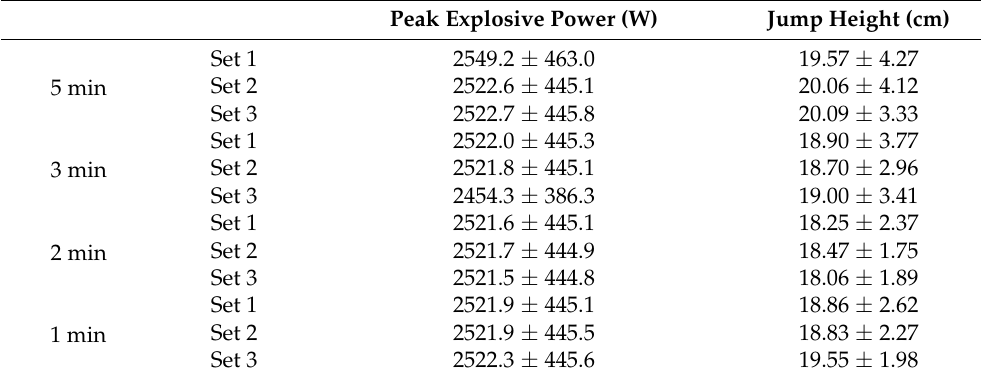
EMG indices, EMG intensity and MPF are used as indicators of muscle fatigue. Table 3 lists the EMG intensity of the 9 tested muscles at each set and group. When muscles are fatigued, the EMG intensity should increase whereas the MPF should decrease. However, we did not find significant differences in EMG intensity for the tested muscles among sets and among groups for GM ( p = 0.34), RF (p = 0.57), VM (p = 0.43) VL ( p = 0.55), BF ( p = 0.09), TA ( p = 0.56), MG ( p = 0.82), LG ( p = 0.84), and SO ( p = 0.44). Table 4 shows the EMG mean power frequency (MPF) of the 9 tested muscles for each set and group. No significant differences in EMG MPF were found among sets and among groups for GM ( p = 0.95),